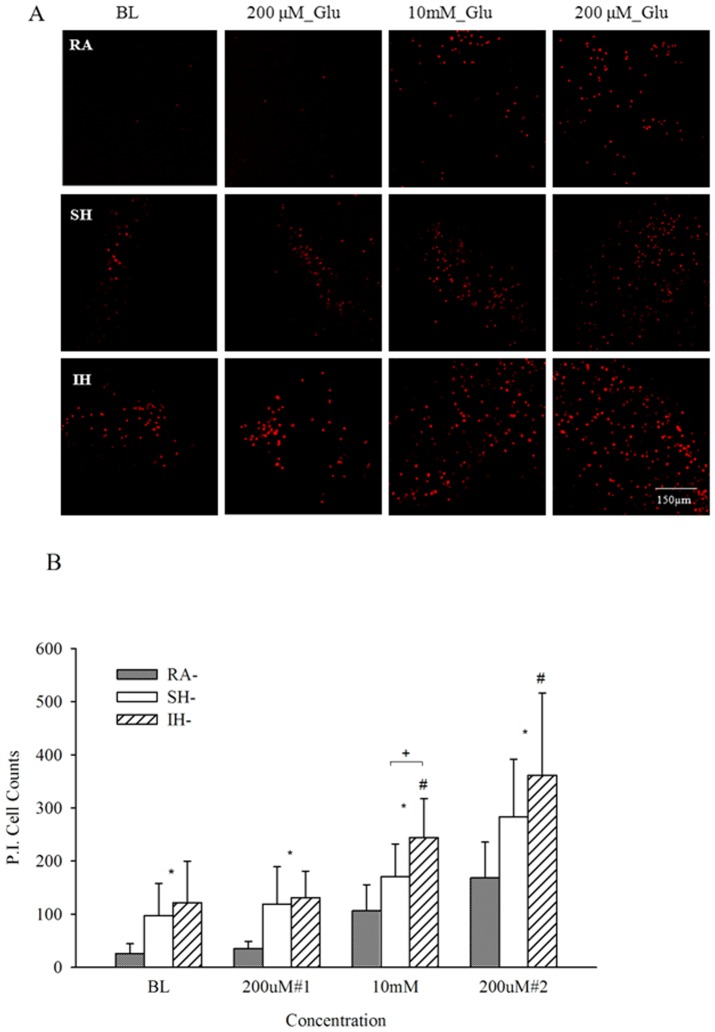
Intermittent hypoxia decreases cell viability and impairs glutamate response.Propidium iodide staining (A) and quantification of PI positive cells presented as mean + SD (B) of slices exposed to 7 days RA, SH or IH at baseline (BL), after 200 µM glutamate, and 10 mM glutamate, followed by a second 200 µM glutamate challenge. n = 12–18. *: At all concentrations RA- < SH- & IH- (p<.001). + At 10mM: SH- < IH- (p<.05). # At 10 mM & 200 µM#2: BL < SH- & IH- (p<.05 and p<.001 respectively).